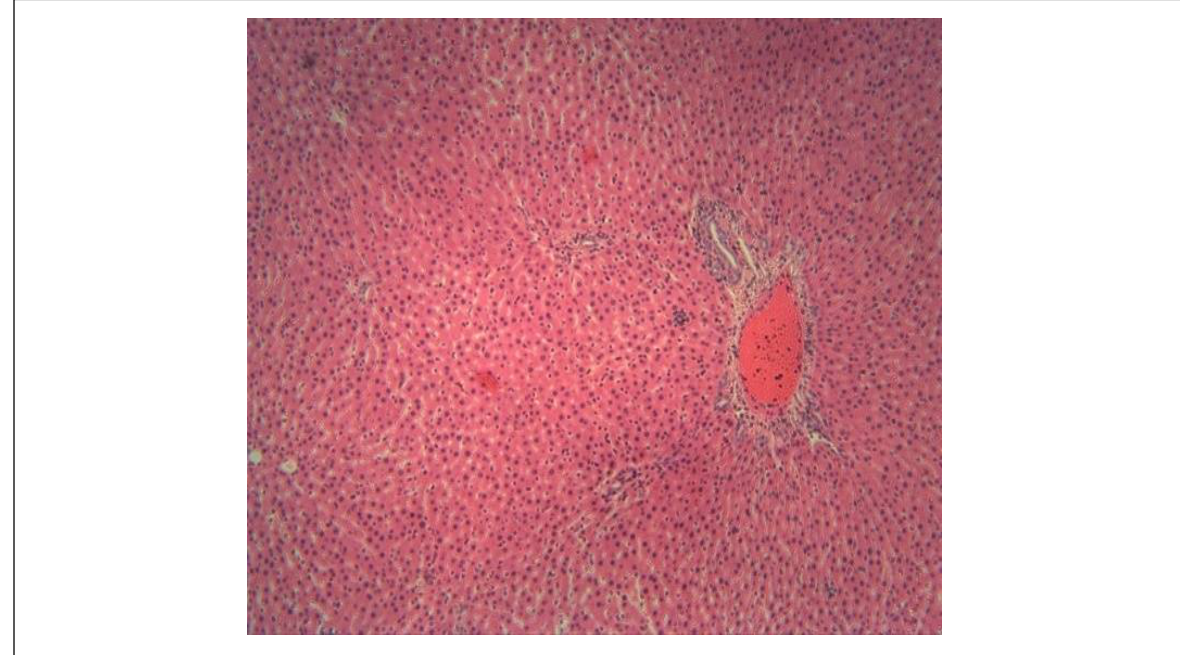
Photomicrographs of the section of the liver of group B rats administered with 400 mg/kg leaf extract of N. laevis + 8,000 mg/kg MSG showed well preserved liver architecture, mild portal inflammation without interface hepatitis, mild lobular hepatitis without necrosis and steatosis and dilated central vein. (Mg X400)